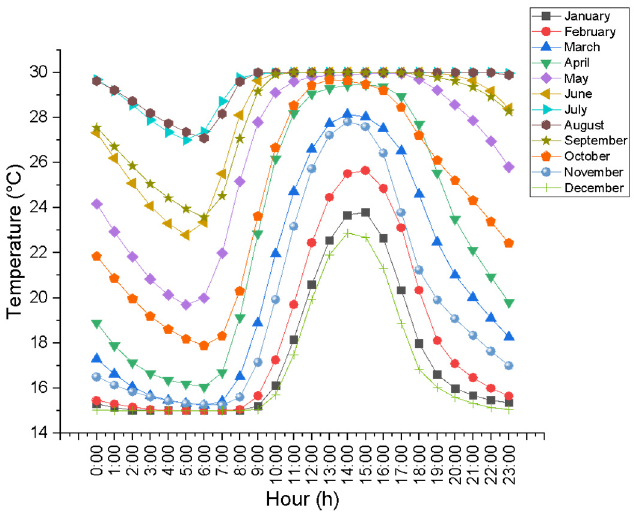
Figure 16. Daily behavior of temperatures inside the greenhouse heated with GHP.